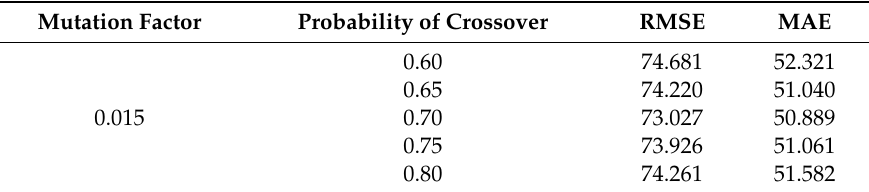
Table 6. The forecasting results with di ff erent probabilities of